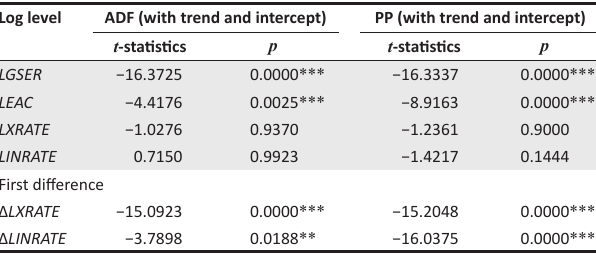
TABLE 5: ARDL short-run error correction estimates.